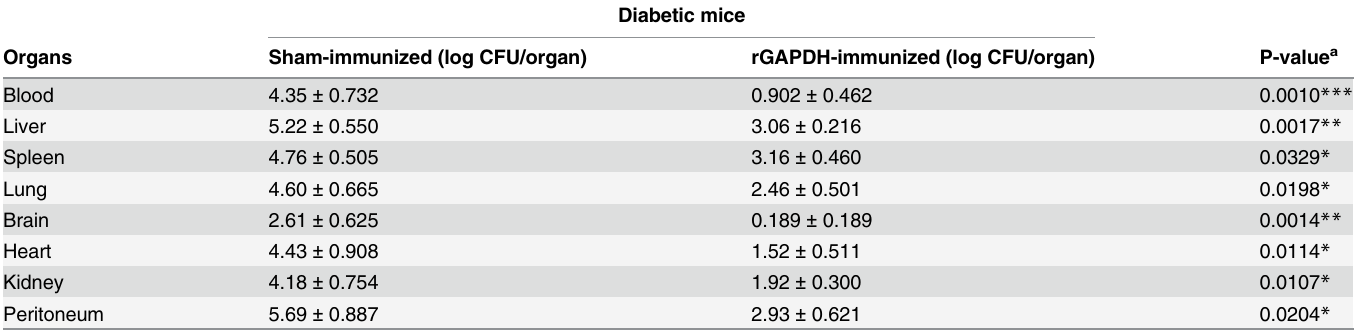
Mice were killed 18h post-infection and the organs collected for bacterial counts. Values are expressed as mean ± S.E.M.; Number of animals Sham- immunized = 8. rGAPDH-immunized = 9; a Student ’ s t